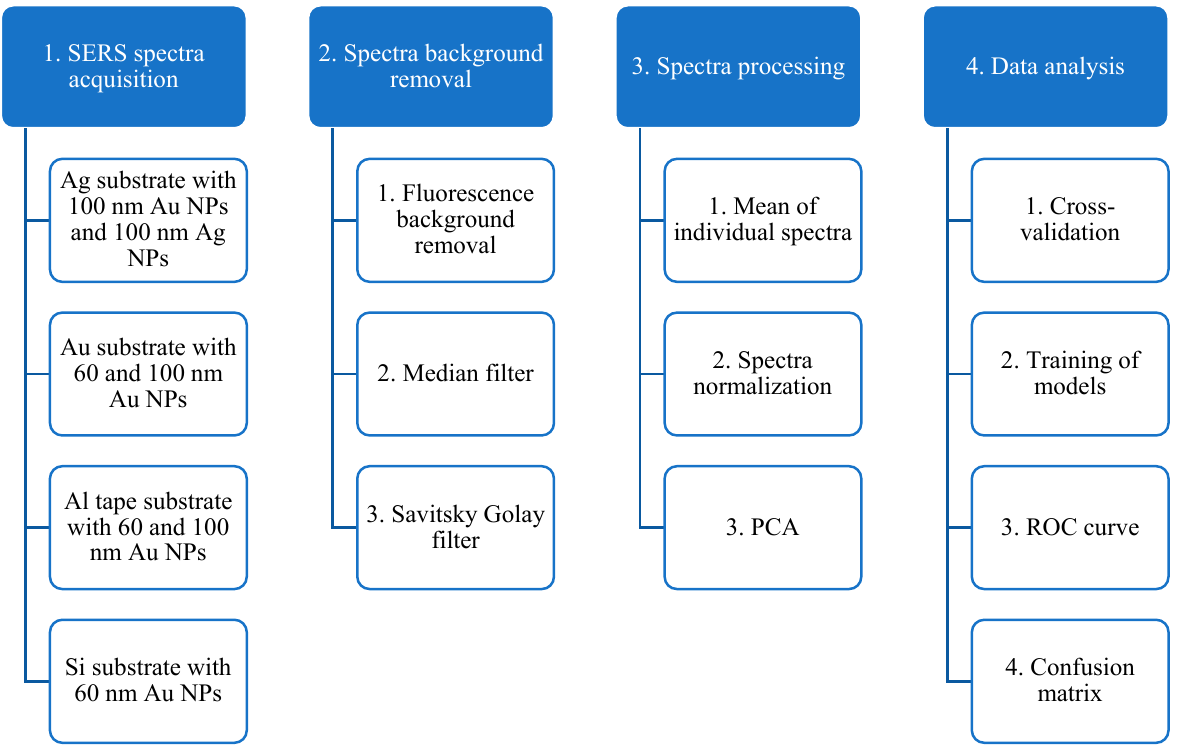
Figure 1. Employed analysis methods in the current work.